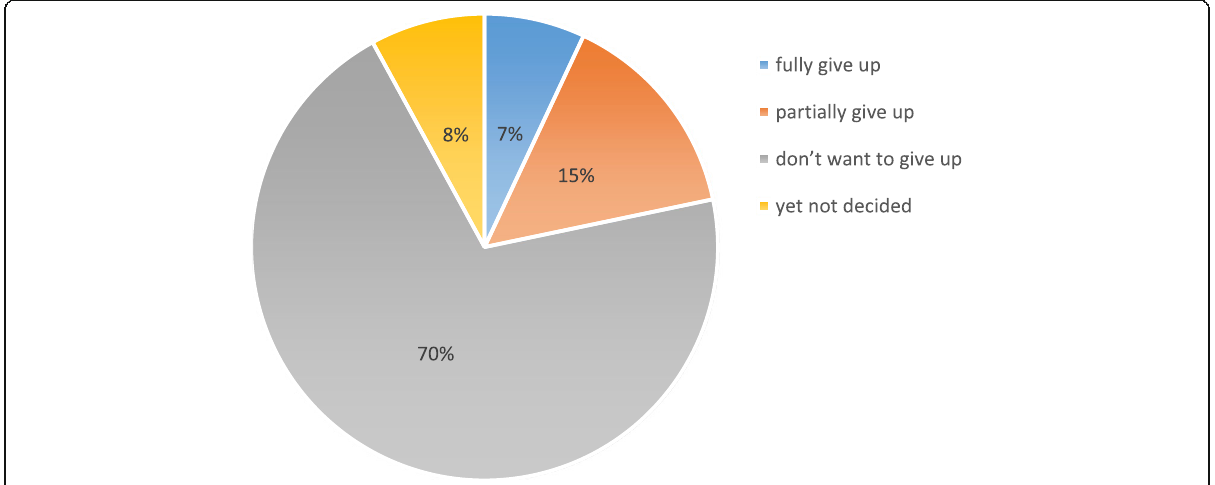
Fig. 2 Nyangatom ’ s opinions on traditional livelihood strategies about